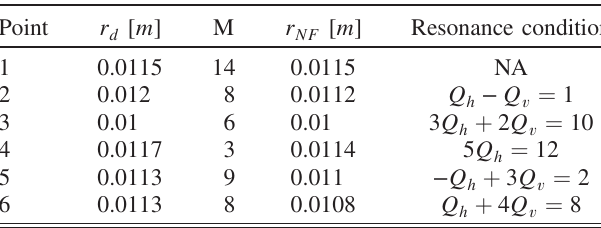
TABLE I. Dynamic apertures for the six points in Fig. 8 calculated with averaging over the dynamics ( r d ) and with normal forms ( r NF ). M is the angular grid size for r d